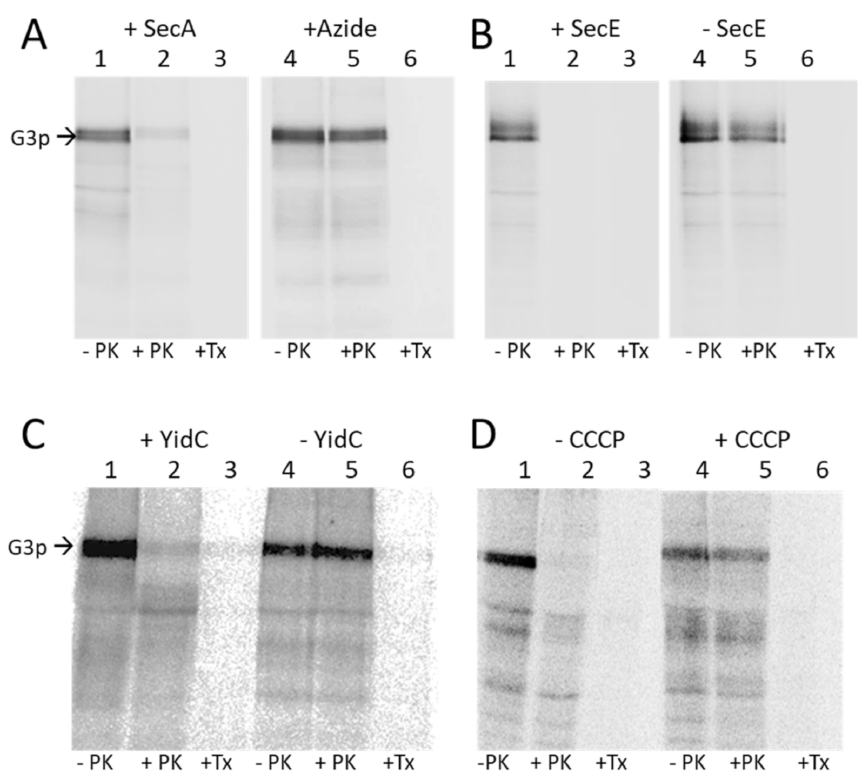
Figure 4. Membrane insertion of G3p requires SecAYEG and YidC and the electrochemical mem- brane potential. ( A ) The insertion of G3p was tested in MC1061 (lanes 1–3) and in azide-treated MC1061 (lanes 4–6). The exponentially growing cells expressing G3p were pulse labelled with 35 S-methionine/cysteine for 3 min and chased with L-methionine/cysteine for 2 min, converted to spheroplasts (lane 1, 4) and digested with proteinase K (lanes 2, 5) or treated with Triton-X-100 and then protease digested (lanes 3, 6). The cells were acid-precipitated, immunoprecipitated and analysed by PAGE and phosphorimaging. ( B ) MG1655 cells were grown in the presence of arabinose, which allows expression of SecE (lanes 1–3), or in the absence of arabinose, which depletes the SecE (lanes 4–6), and treated as described for ( A ). ( C ) MK6 cells grown in the presence of arabinose ex- pressing YidC (lanes 1–3) or in the absence of arabinose that depletes YidC (lanes 4–6) were treated as described for ( A ). ( D ) MC1061 cells (lanes 1–3) and CCCP-treated MC1061cells (lanes 4–6) expressing G3p were analysed for G3p insertion by protease mapping as described for ( A